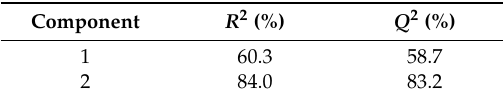
Table 1. Percent cumulative sum of squares explained ( R 2 ) and predicted ( Q 2 ) by the Principal anode